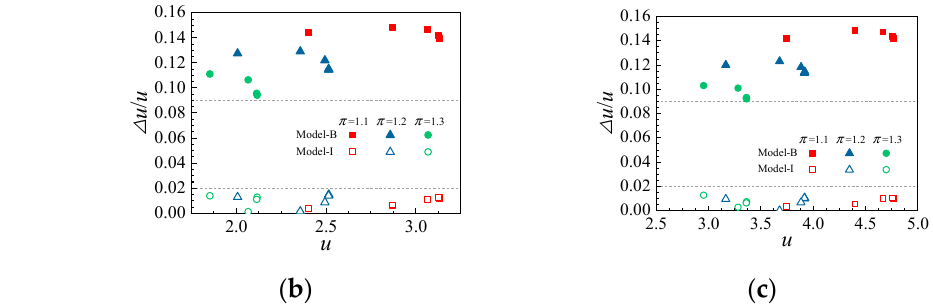
Figure 10. The comparison of simulation error of the theoretical VABI models: ( a ) A VABI = 0.8; ( b ) A VABI = 0.6; ( c ) A VABI = 0.4.